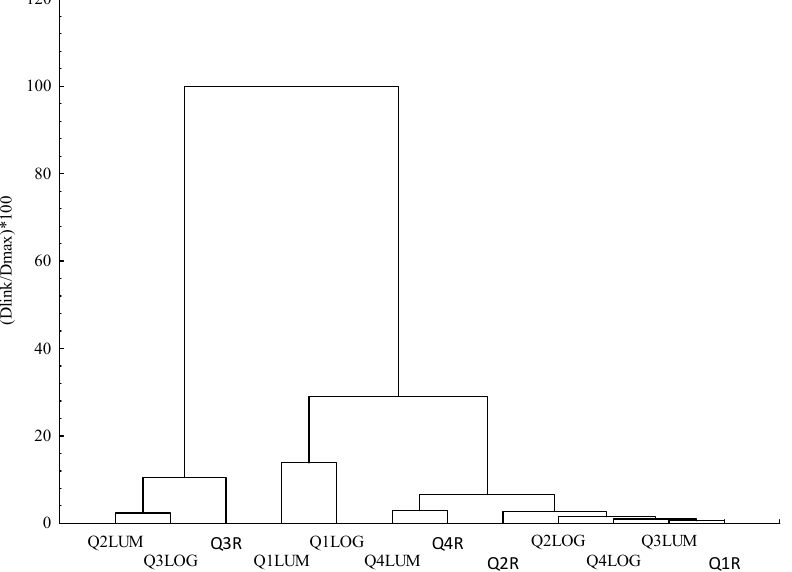
Figure 9. Decomposition of the time series of construction activities, including irregular fluctuation indices in Hyrcanian forest in 1992–2015.